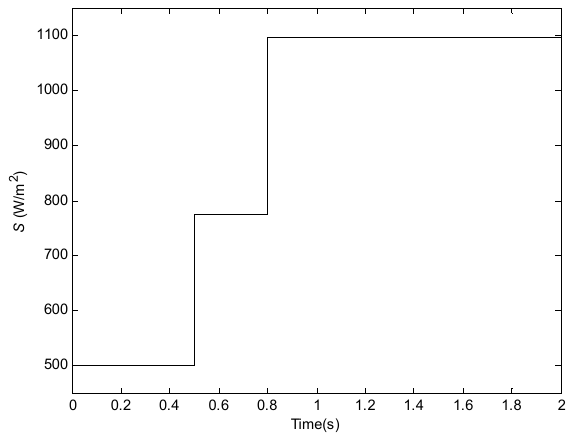
Figure 30. curve under different step size conditions. Figure 30. Curve under different step size